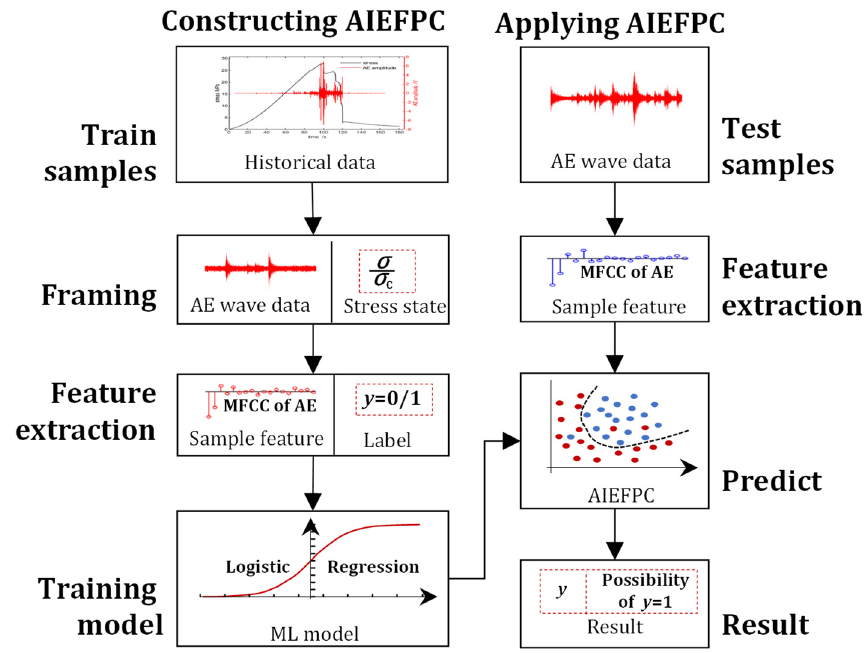
Figure 1. Methodology adopted for constructing and applying AIEFPC model by coupled use of machine learning and automatic speech